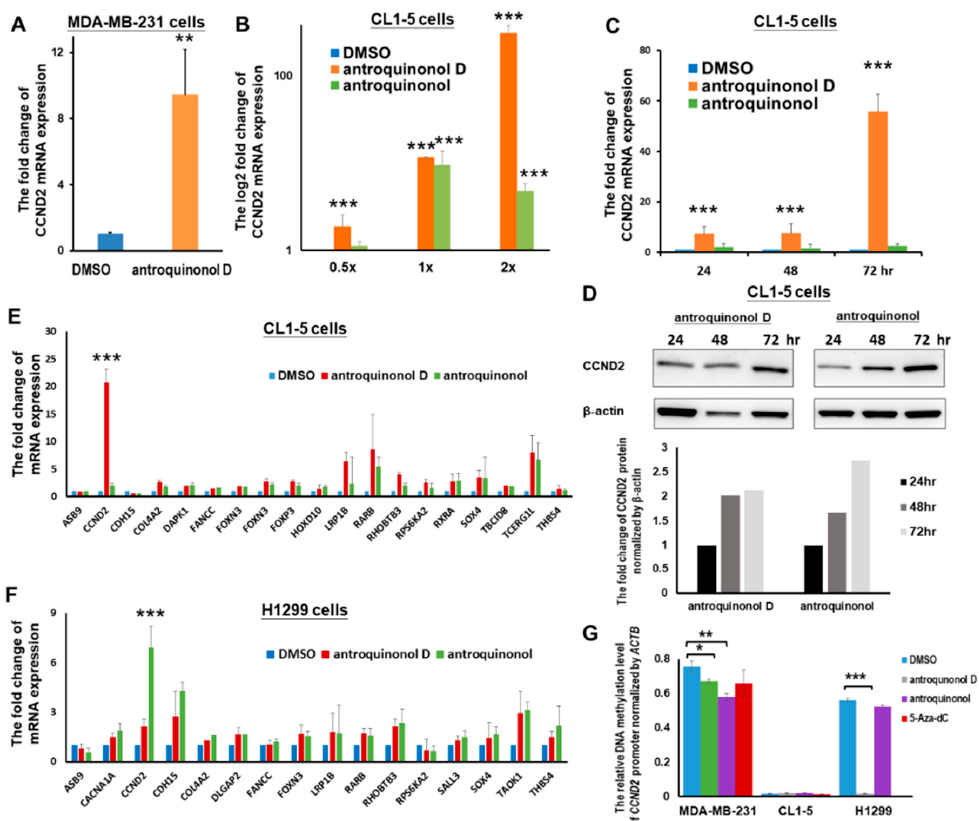
Figure 5. CCND2 can be induced by antroquinonol D and antroquinonol. CCND2 mRNA expression was induced by antroquinonol D in the MDA-MB-231 breast cancer cell line ( A ) and in lung adenocarcinoma cell line CL1-5 in a dose-dependent manner ( B ). The CCND2 mRNA ( C ) and protein expression levels ( D ) were also induced in a time-dependent manner. ( E ) Antroquinonol D induced CCND2 mRNA expression compared with that of other tumor suppressor genes in CL1-5. The antroquinonol D analog antroquinonol also induced CCND2 expression in the H1299 lung cancer cell line ( F ). ( G ) CCND2 DNA methylation levels were analyzed by qMSP. The data are presented as the means ± SD. * p ≤ 0.05, ** p ≤ 0.01, *** p ≤ 0.001.